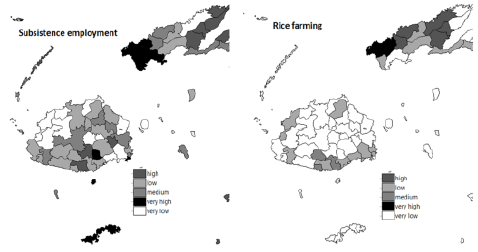
Figures 7a. Fiji islands map showing degrees of immigration (as percentage of population) per tikina . Range: under 45 to 100. Figure 7b. The country‘s map showing the number of sugarcane farmers per tikina. Range: 0 to 7486.